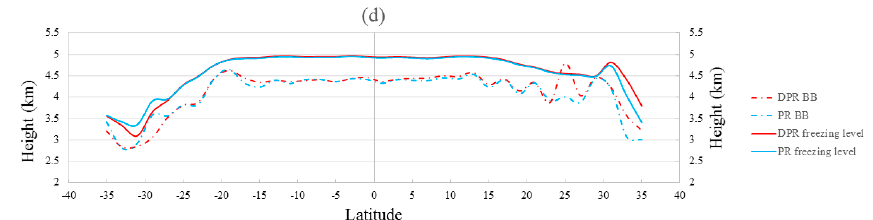
Figure 12. The latitudinal zonal distribution map for: ( a – c ) precipitation; and ( d ) height of freezing level and BB based on the coincident events. Panels ( a , d ) are based on the coincident events in Group 1; Panel ( b ) is based on Group 2; and Panel ( c ) is based on Group 3. All data are resampled to a spatial resolution of 2°.